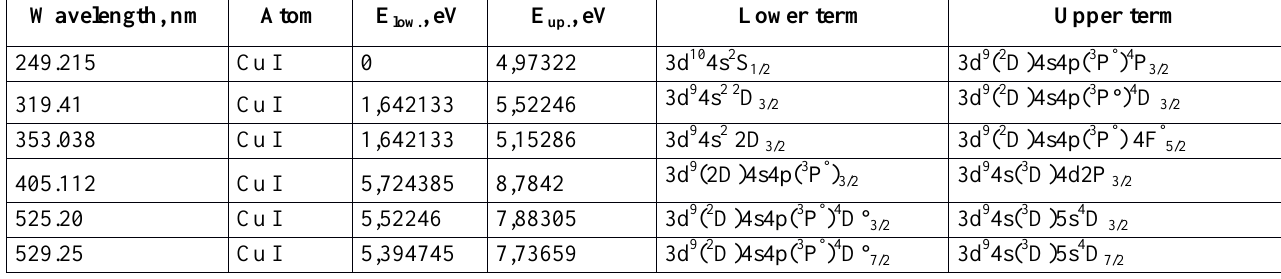
Table 2 . The results of the identification of objects of the radiation of the discharge plasma above the surface of a 5% solution of copper sulfate at air pressure of 6.5